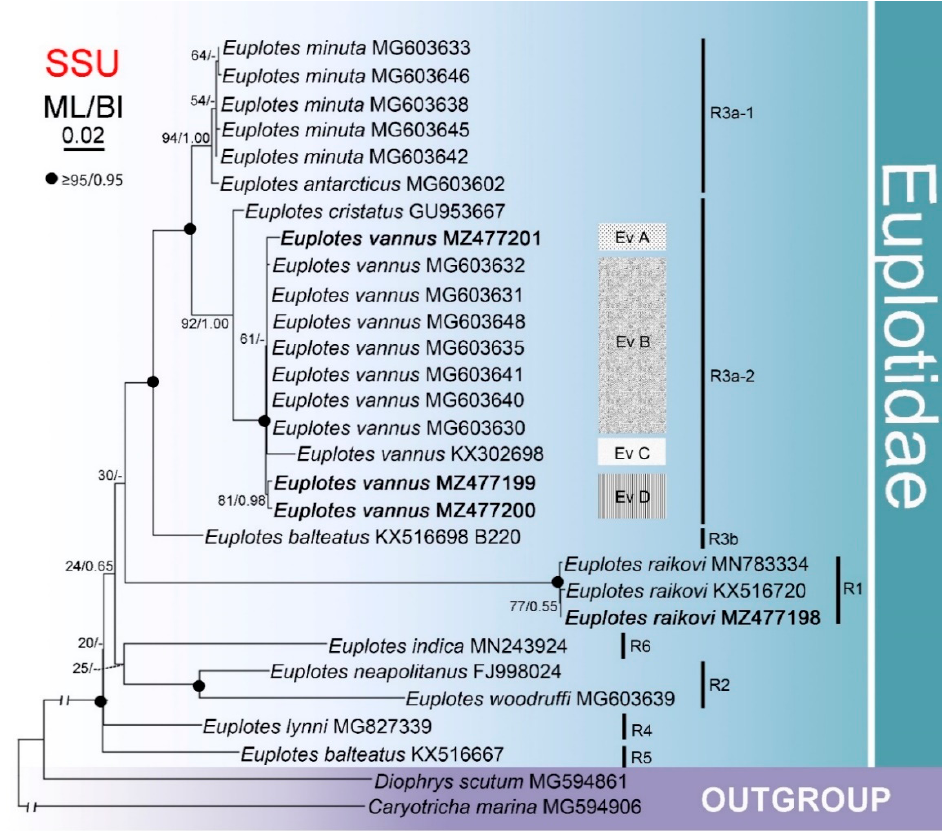
Figure 3. Maximum likelihood (ML) tree inferred from SSU rDNA sequences of 10 Euplotes species that had isolates for which CO1 sequence data are also available. Nodal support is given for both ML and BI analyses. Newly sequenced species are shown in bold. A hyphen ( − ) reflects disagreements in topology between the BI and ML trees. R1–6 represent different clades and Ev A–D for groups of Euplotes vannus . The scale bar corresponds to two substitutions per 100 nucleotide positions.